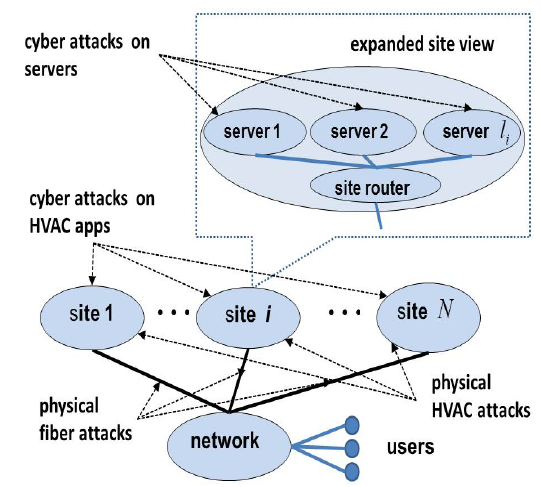
Figure 1. Cloud computing infrastructure with N server